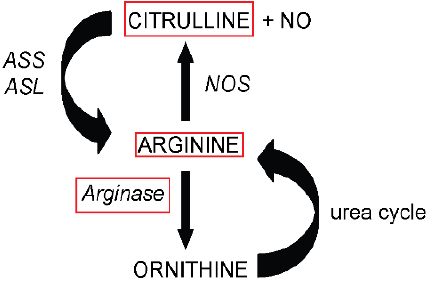
Figure 2. Schematic overview of the relevant metabolic pathways of